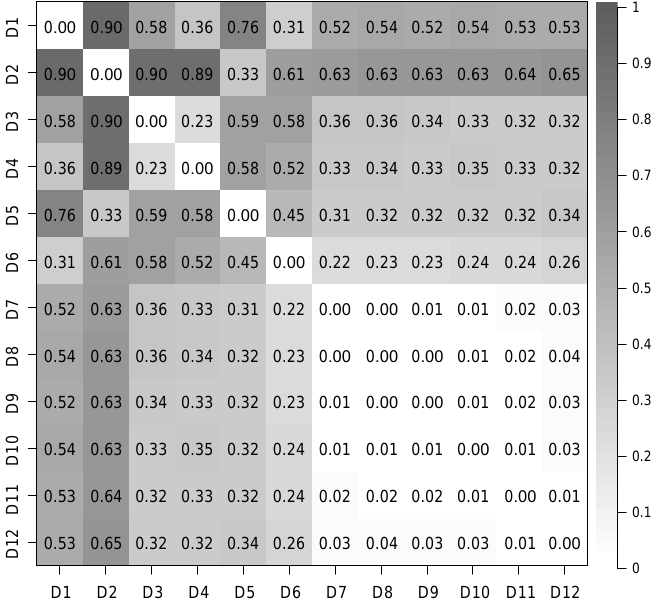
Figure 7. Distance of correlation between each pair of time-series of latent features extracted from the 12 datasets by using PCAs.